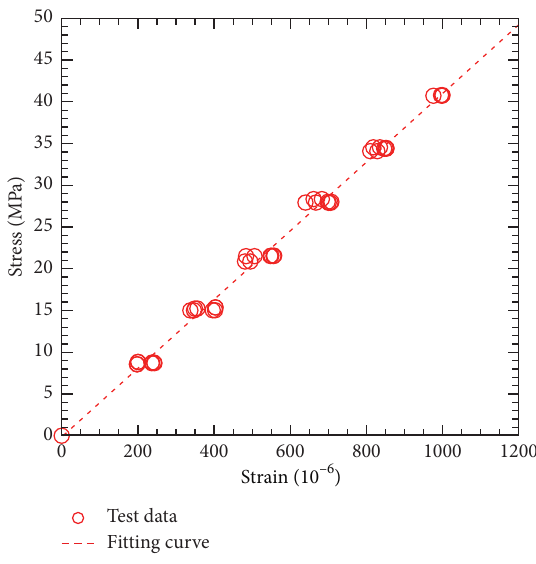
Figure 3: Elastic modulus of insulator A6. Table 2: Elastic moduli of individual